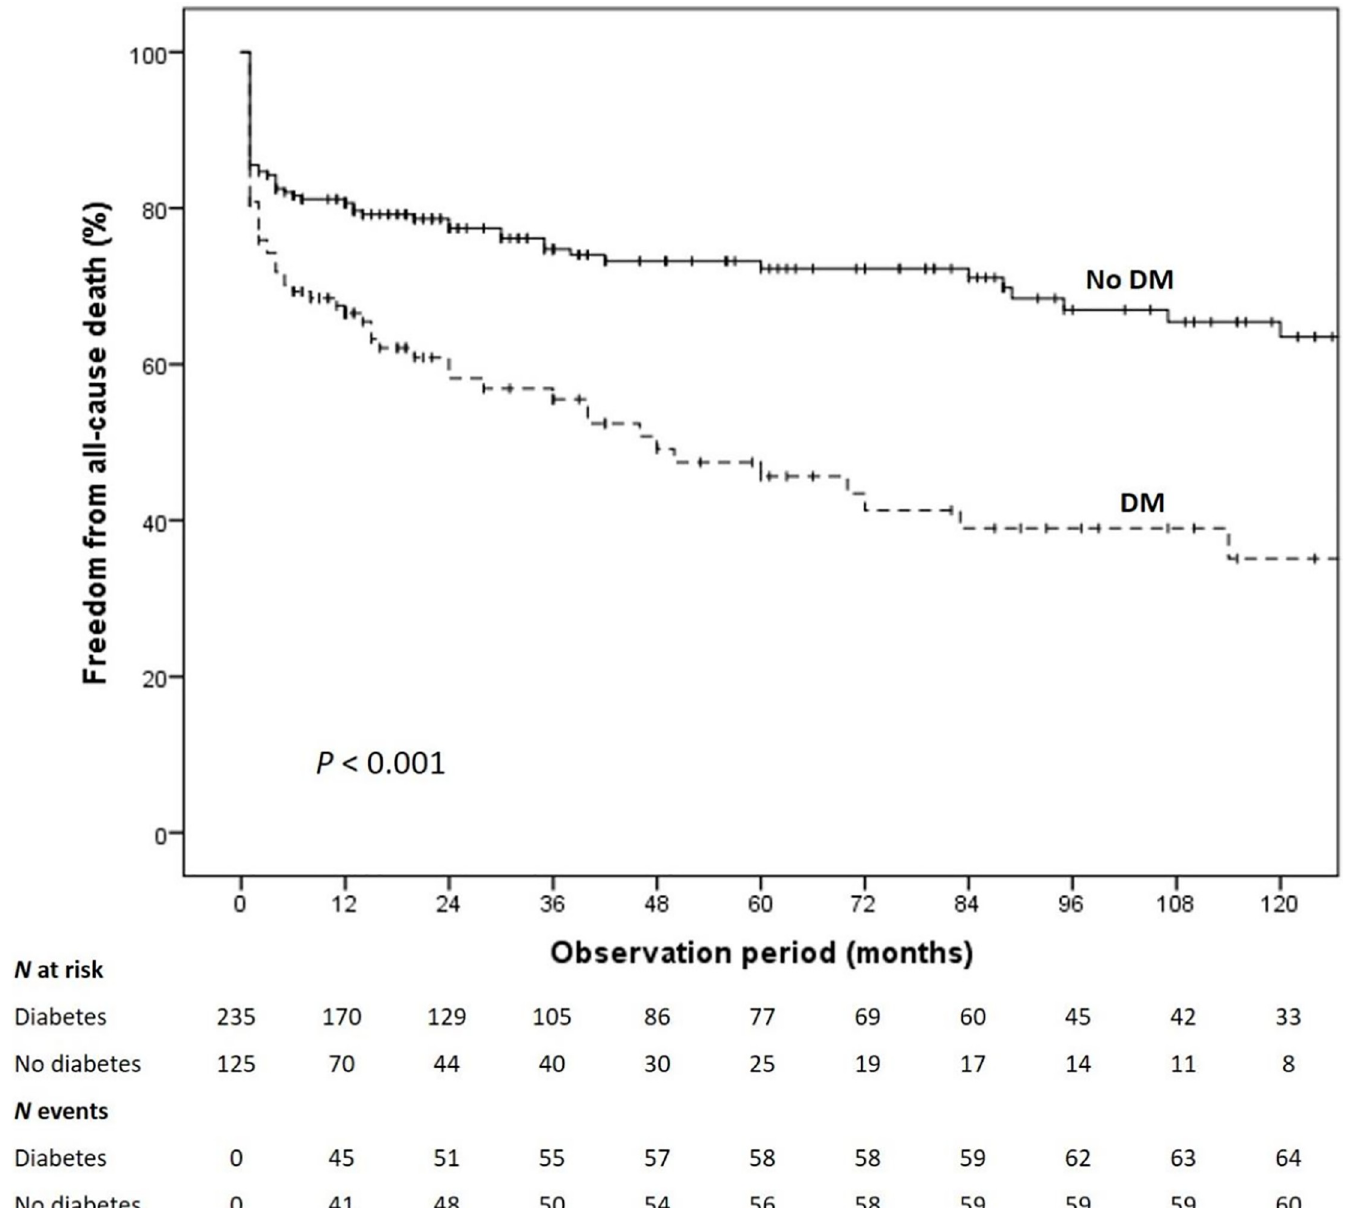
Fig 2. Kaplan Meier survival free from all-cause death in diabetic vs. non-diabetic patients. DM: diabetes mellitus.